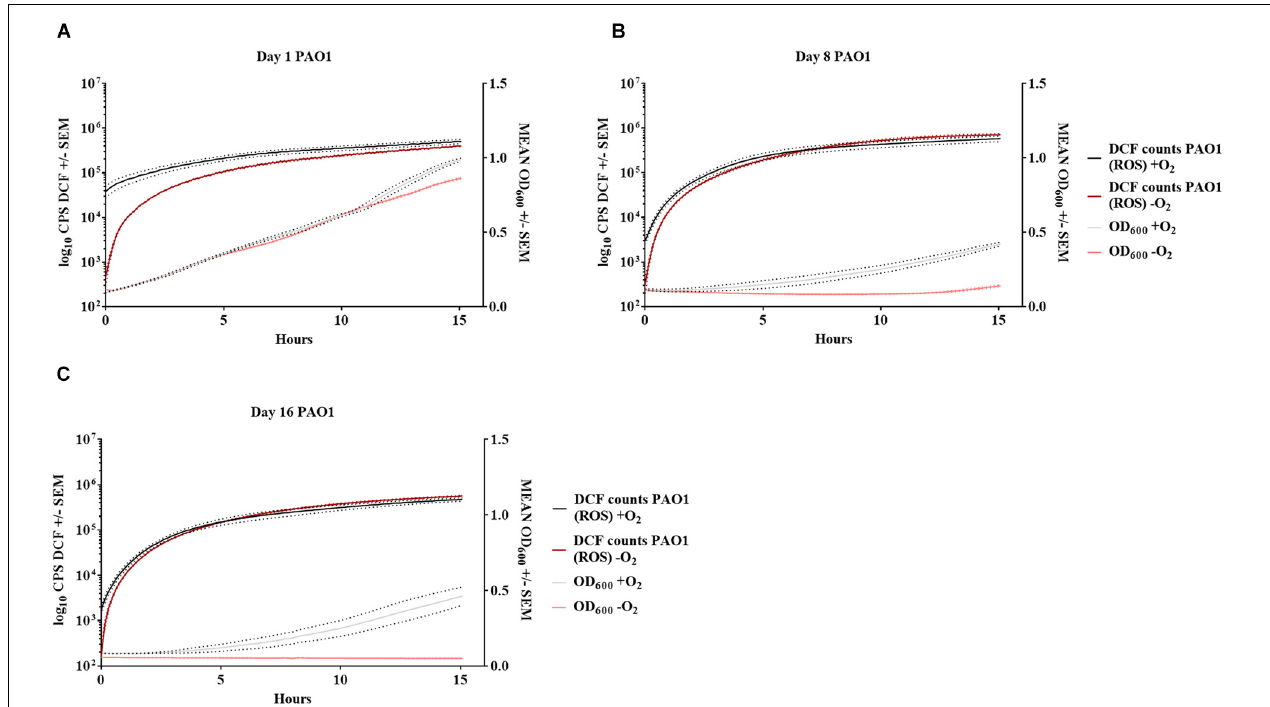
FIGURE 8 | Increase in reactive oxygen species affects growth of anoxically conditioned Pseudomonas aeruginosa (PAO1) over time. Determination of reactive oxygen species (ROS) and optical density (OD) at day 1 (A) , 8 (B) and 16 (C) for anoxically (–O 2 ) and normoxically (+O 2 ) conditioned PAO1. ROS was measured as counts per second (CPS) when 2 (cid:48) ,7 (cid:48) dichlorodihydrofluorescein diacetate was converted to 2 (cid:48) 7 (cid:48) -dichlorofluorescein (DCF). Growth was measured with optical density (OD 600 ) simultaneously to ROS measurement. Data is generated from 99 continuously measurements presented as a solid line with dots representing ± SEM ( n =